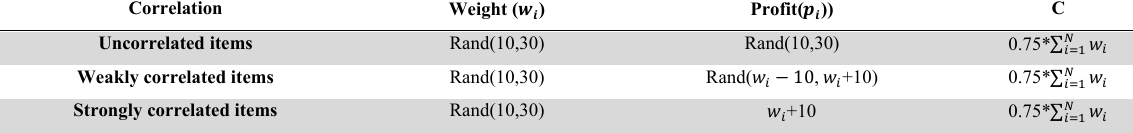
Correlation characteristics of profit and weight for large-scale 0-1 knapsack problem Correlation Uncorrelated